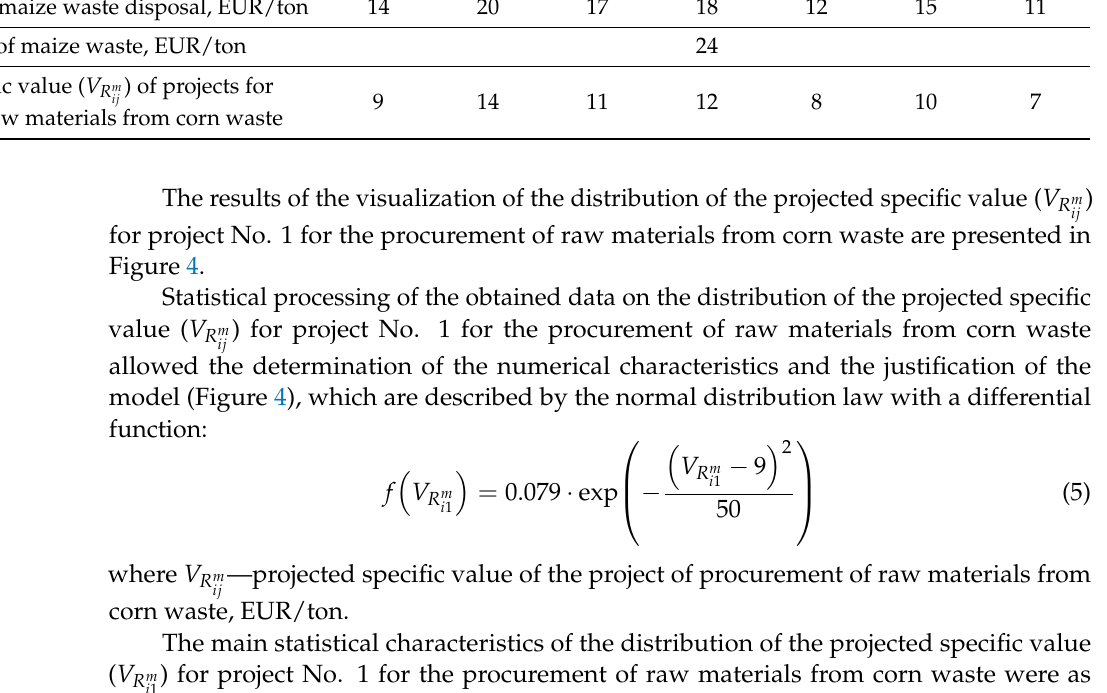
) of individual projects for the procurement of ij